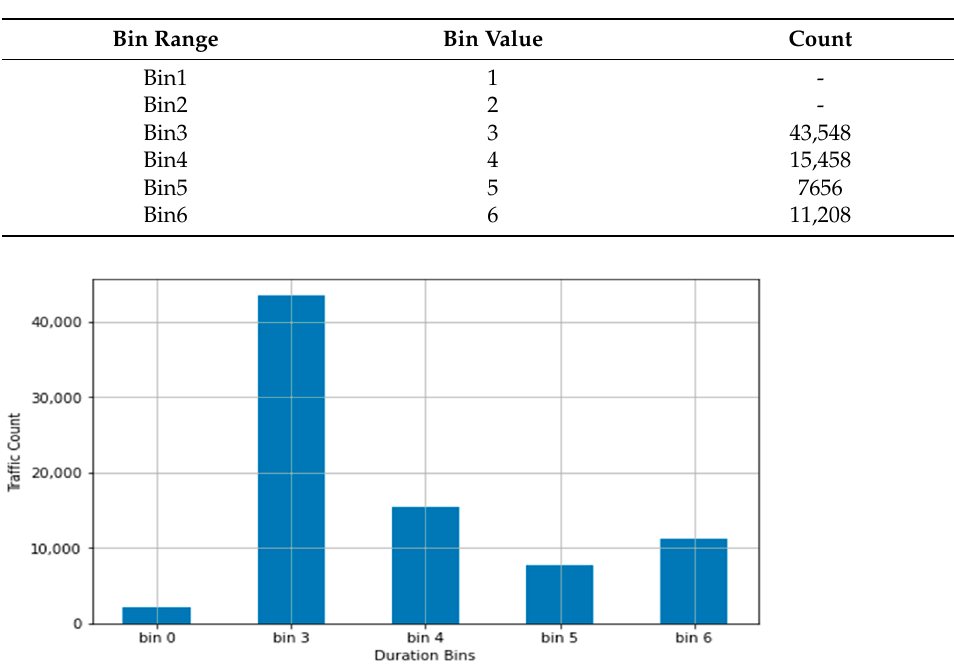
Table 3. Distribution for Duration.